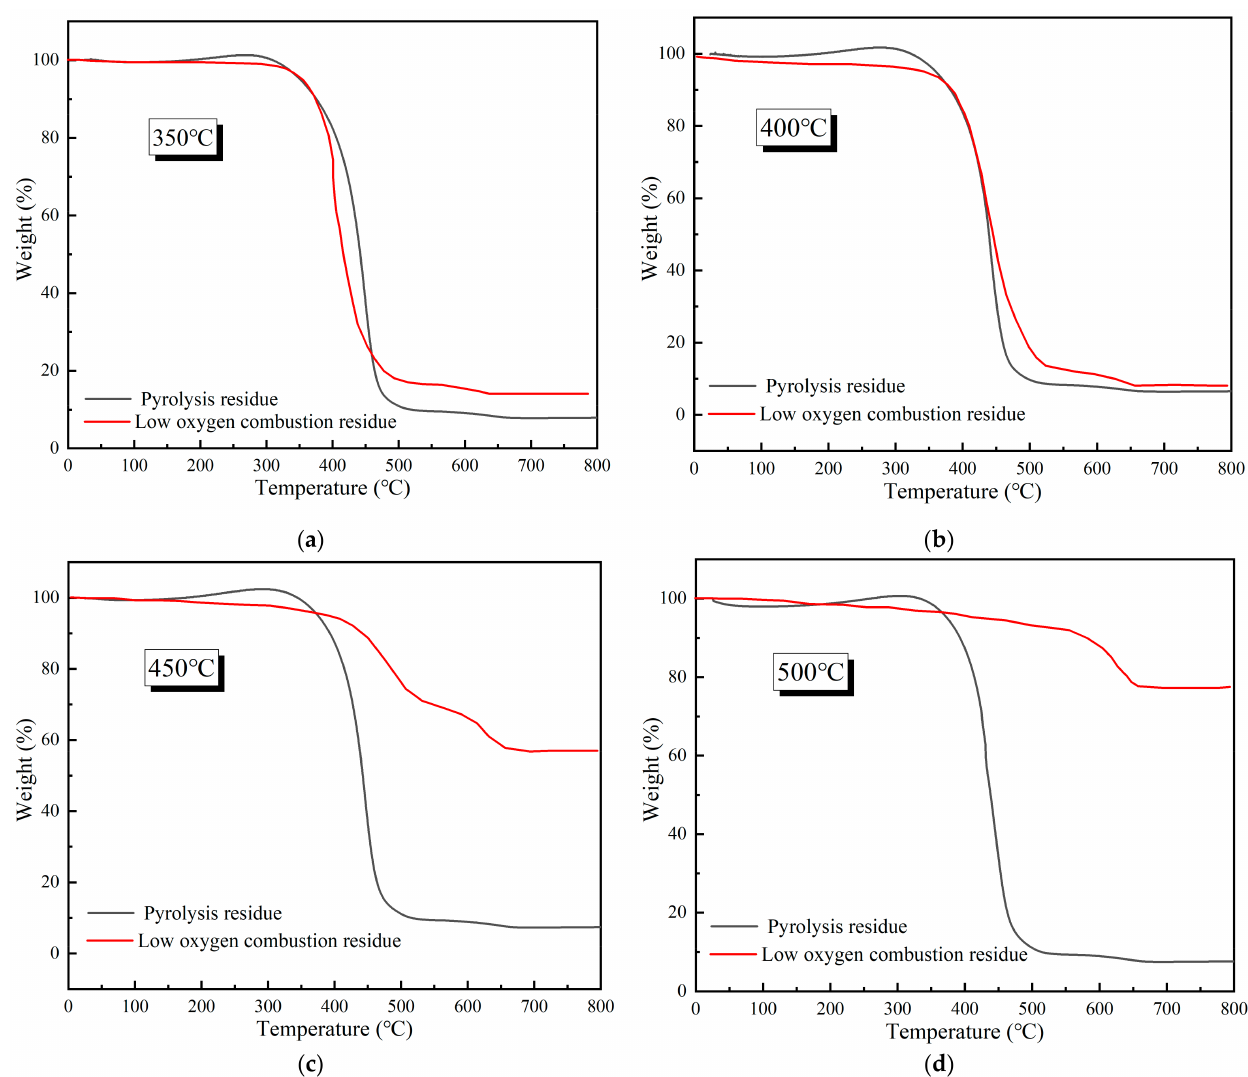
Figure 5. TG curve of the residues of pyrolysis and low oxygen combustion in different constant temperatures. ( a ) The constant temperature is 350 ◦ C, ( b ) the constant temperature is 400 ◦ C, ( c ) the constant temperature is 450 ◦ C, and ( d ) the constant temperature is 500 ◦